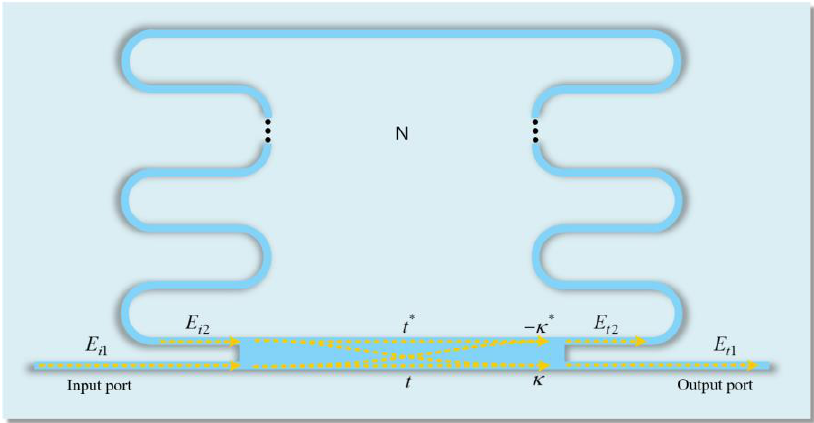
Figure 1. Top-view schematic of the S-bend resonator based on the multi-mode waveguide.